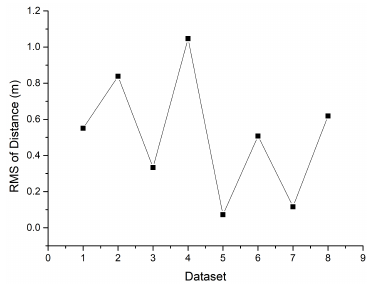
Figure 12. The distance RMS of datasets.